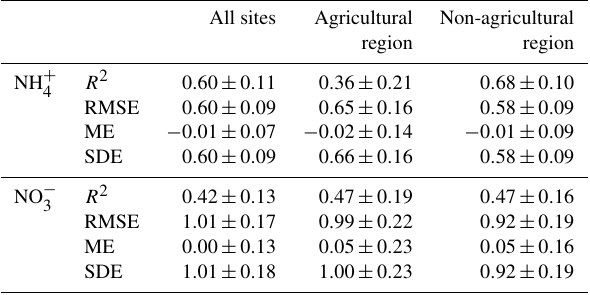
Table 3. Cross-validation statistics (mean ± standard deviation) of Cubist model on the estimation of NH + (mgNkg − 1 ) in soils. The performance of the models was evalu- ated with 10-fold, 50-repeated cross-validation with instance-based corrections. The coefficient of determination ( R 2 ), the root mean squared error (RMSE), estimated bias (ME), and the standard error of estimated bias (SDE) are